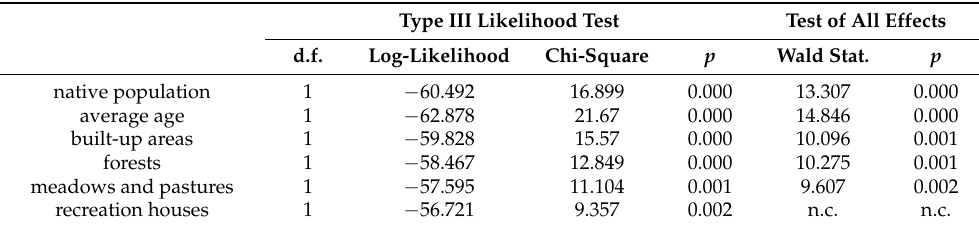
Table 1. Results of a non-parametric regression model for brownfields detected in the year 2004 (Hosmer–Lemeshow = 9.097, p = 0.334; Cox–Snell pseudo R 2 = 0.413).